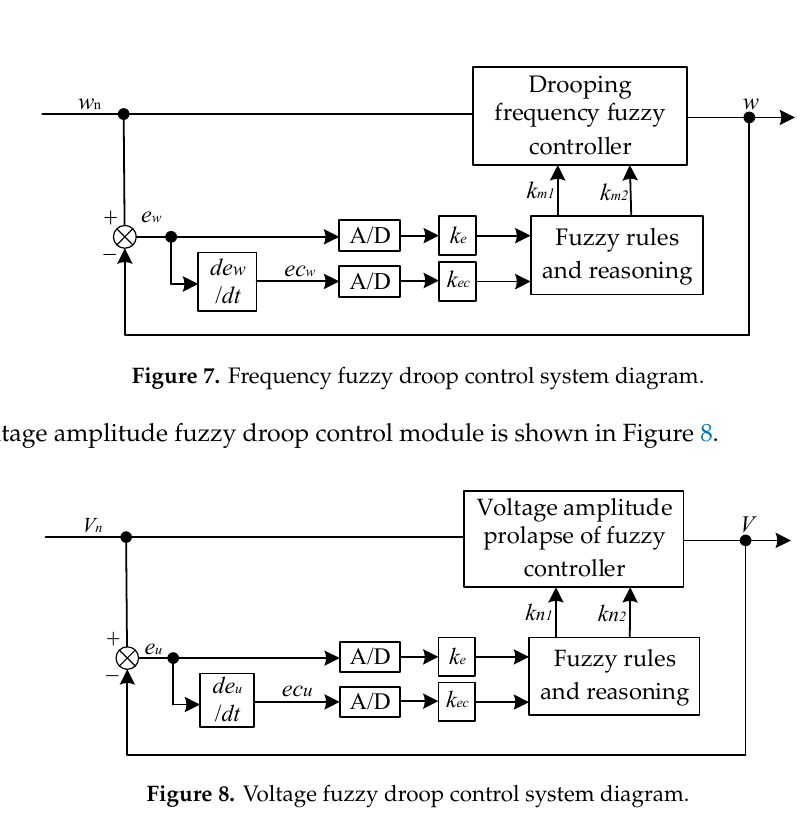
Table 2. Fuzzy control rules of k 1 / k 2